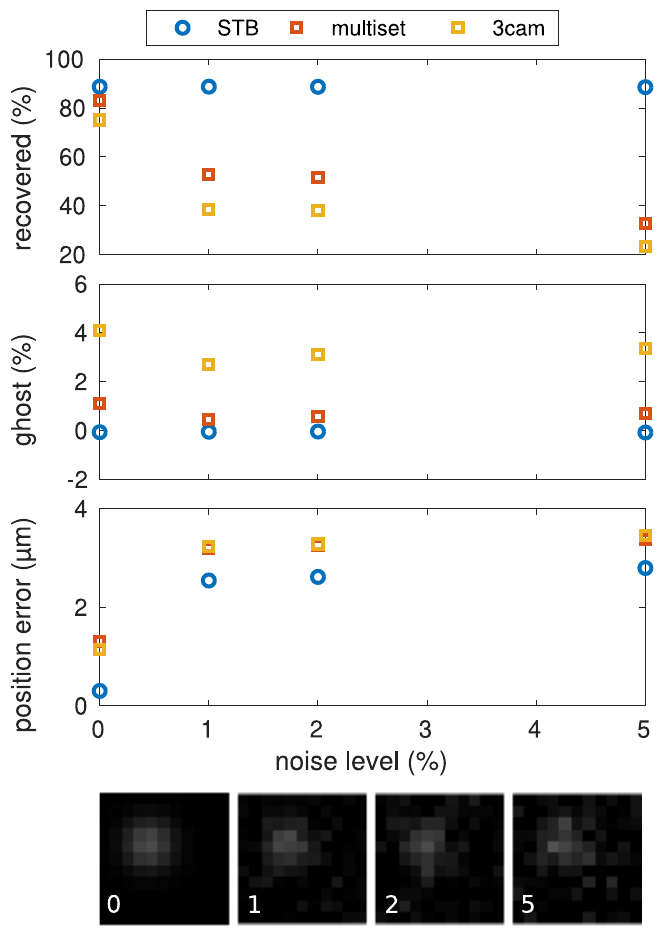
Figure 8. Influence of Gaussian image noise on the algorithms. Below the graphs, the sample images show the particle appearance with noise levels 0%, 1%, 2%, and